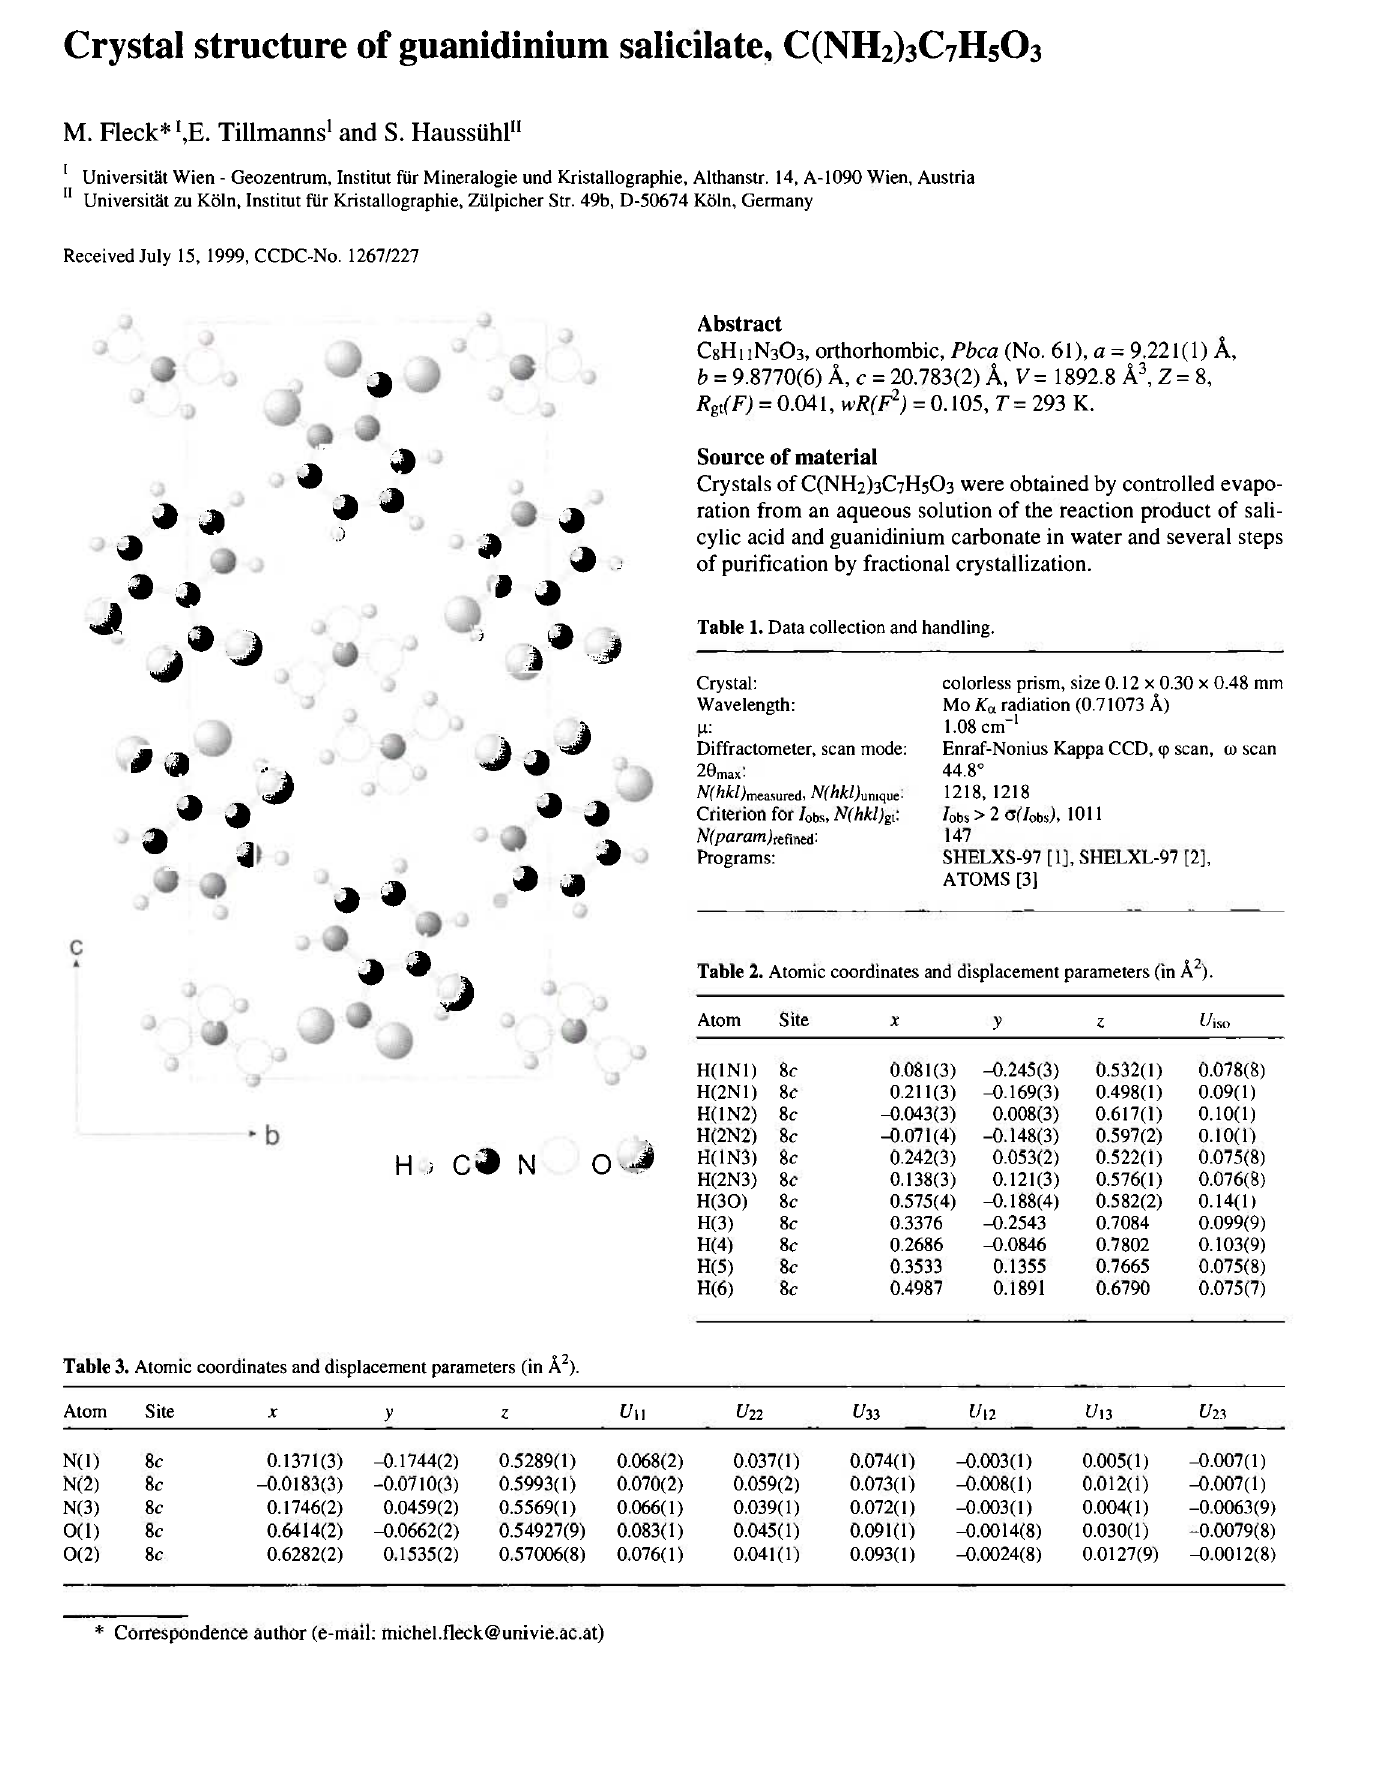
Table 2. Atomic coordinates and displacement parameters (in Ä 2